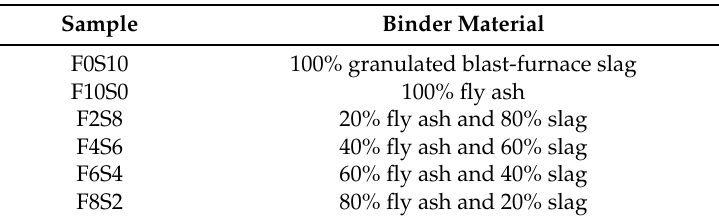
Table 2. Mixture